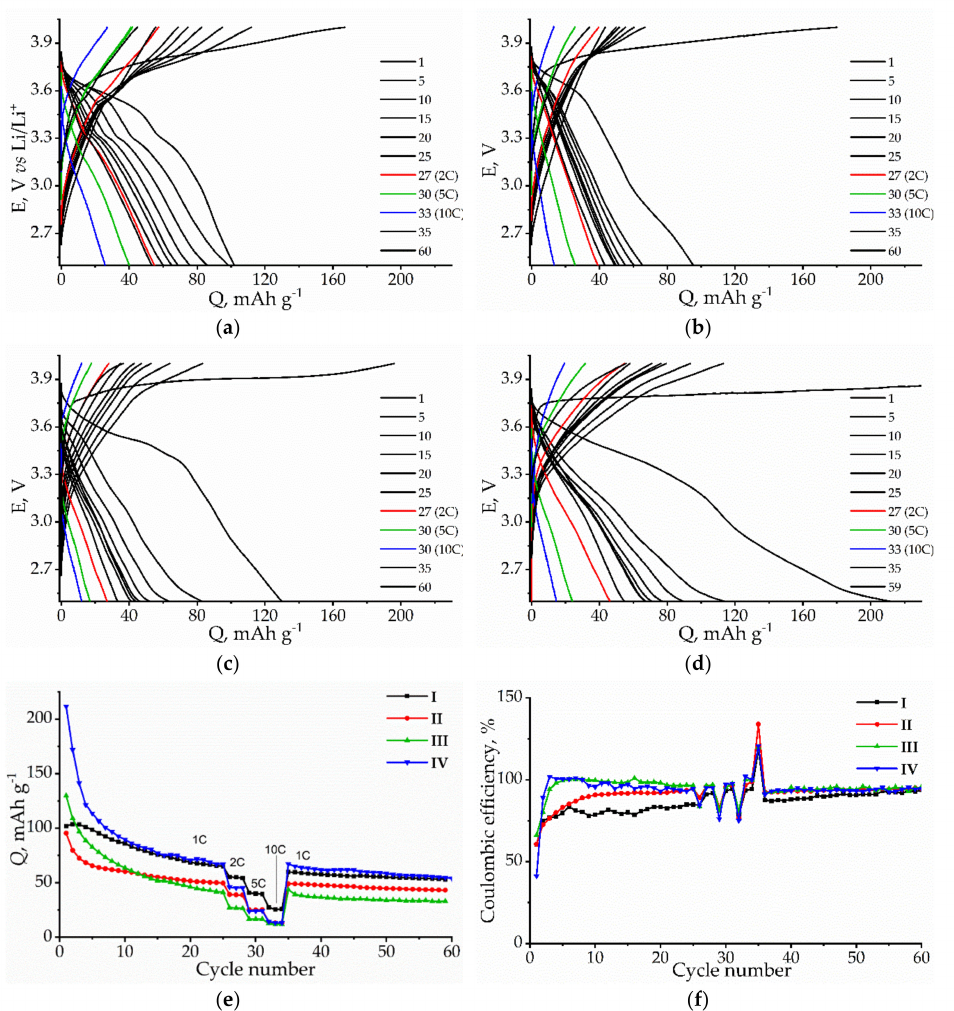
Figure 4. GCD curves for ( a ) I ; ( b ) II ; ( c ) III ; ( d ) IV ; ( e ) cycling performance and ( f ) coulombic e ffi ciencies of all samples at 1C, 2C, 5C, and 10C in 1M LiPF 6 in a 1:1:1 EC:DEC:DMC Li